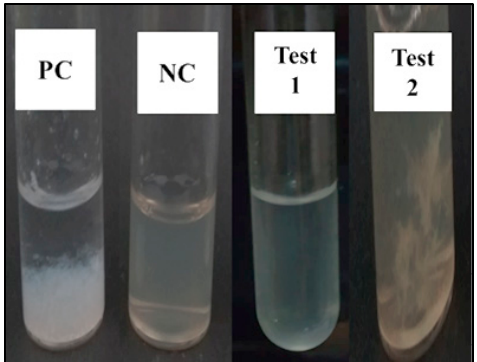
Figure 8. Platelets aggregation of AgNPs (PC, positive control; NC, negative control; Test1, 500 µL of AgNPs; Test 2, 1000 µL of AgNPs).